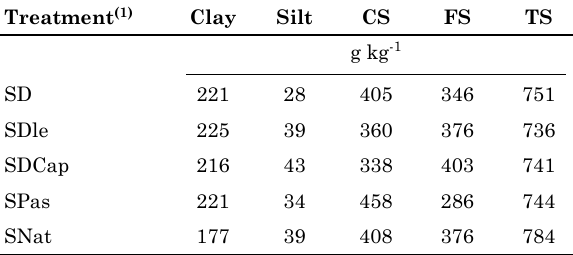
table 2. soil particle size distribution, determined in 2004, for soil from the 0.00-0.20 m layer around the ilha solteira hydroelectric